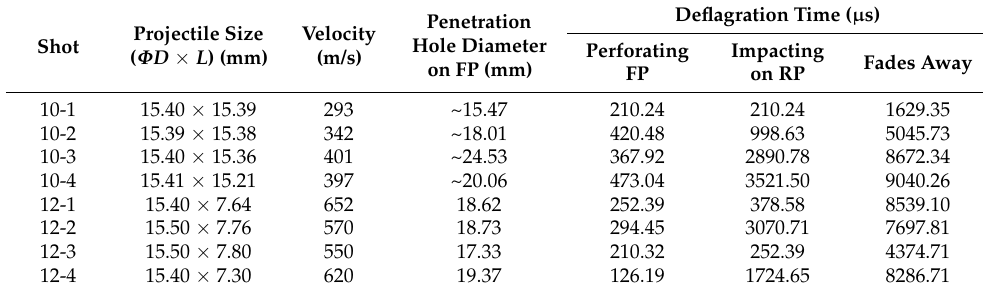
Table 1. Experimental